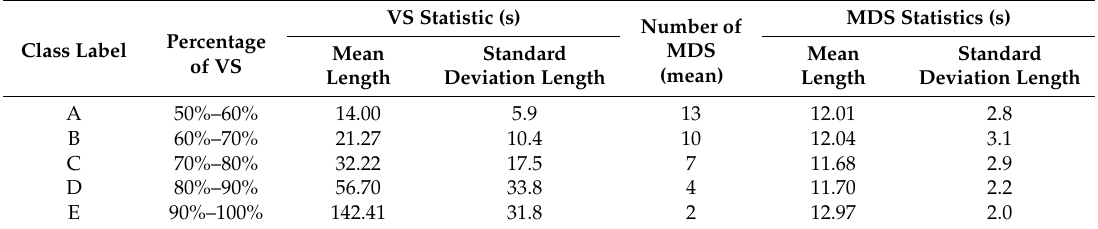
Table 1. Statistics of simulated Missing Data Segments (MDS) and Valid Signal (VS) percentages.